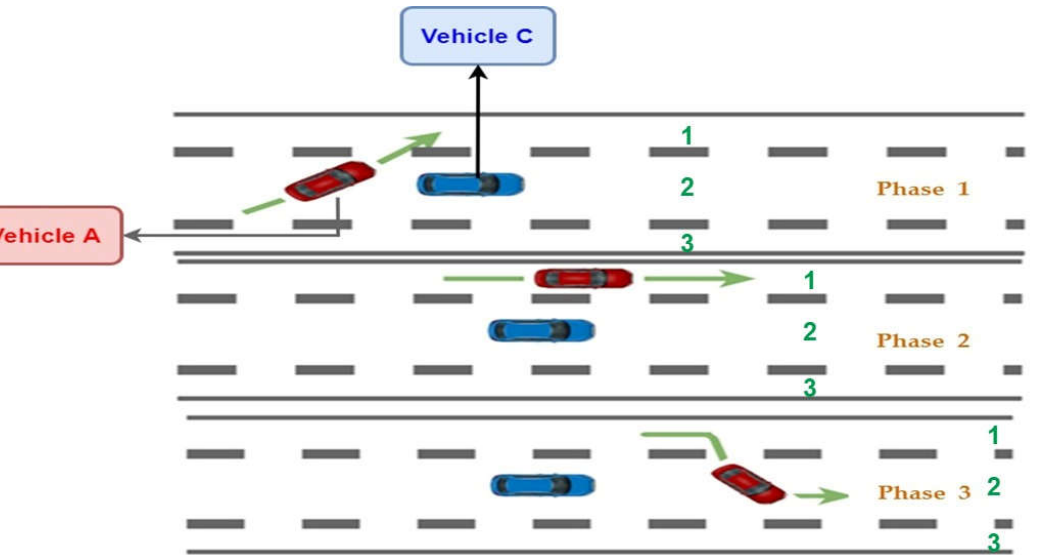
Figure 9. Ego-vehicle parameters showing lower speed of the vehicle A. Figure 10 shows two TIS sensors in vehicle A. Each of the TIS sensors is labeled with a color: the first TIS sensor is labeled red, and has a range of 60 m; d the other TIS sensor is labeled blue, and has a range of 150 m. Vehicle C is represented by a green dot when it is detected by the TIS sensors in ve- hicle A.